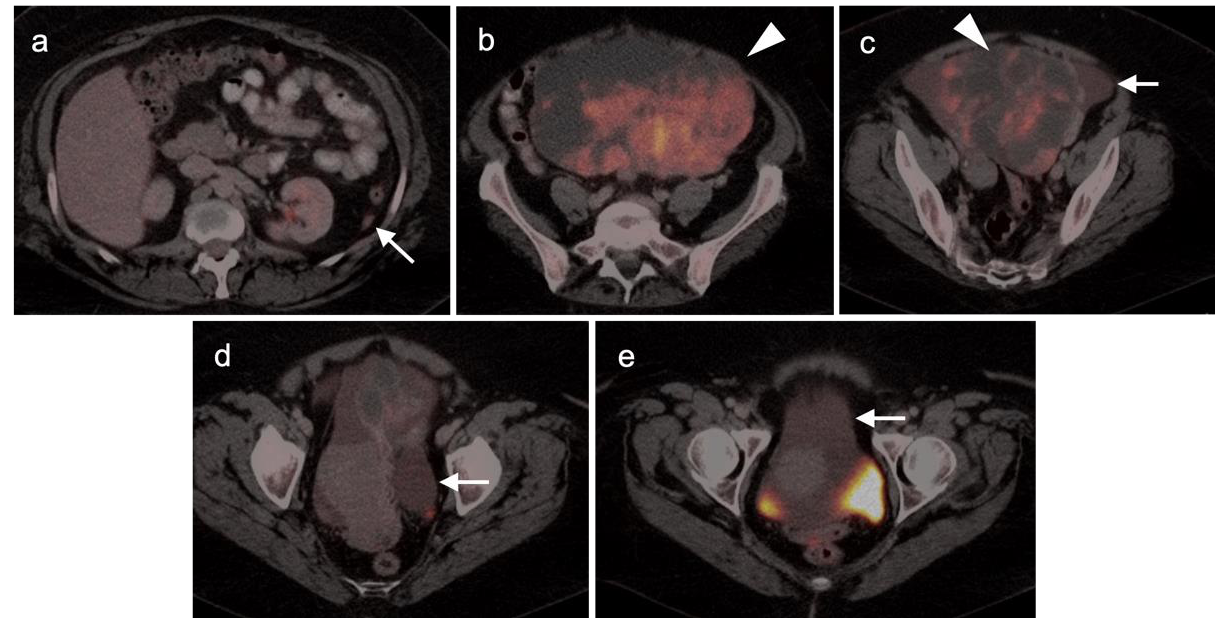
Figure 9. Mucinous cystadenocarcinoma of the ovary with peritoneal spread. ( a – e ) Axial FDG PET- CT images of the abdomen. ( a ) Small peritoneal implant (white arrow); ( b , c ) large mixed attenuation ovarian mass (white arrowheads). The solid components are hypermetabolic. ( c – e ) Areas of subtly metabolically active mucinous ascites (white arrows).